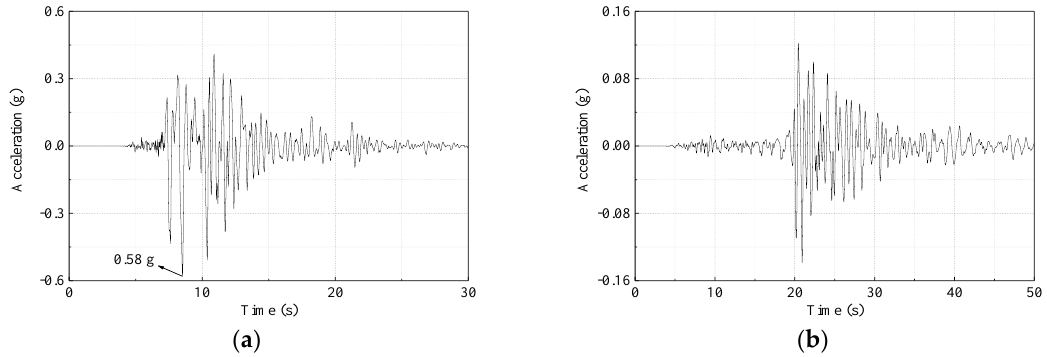
Figure 10. Time series of input acceleration for Daikai station (horizontal direction). ( a ) Port Island and ( b ) HIK station records.